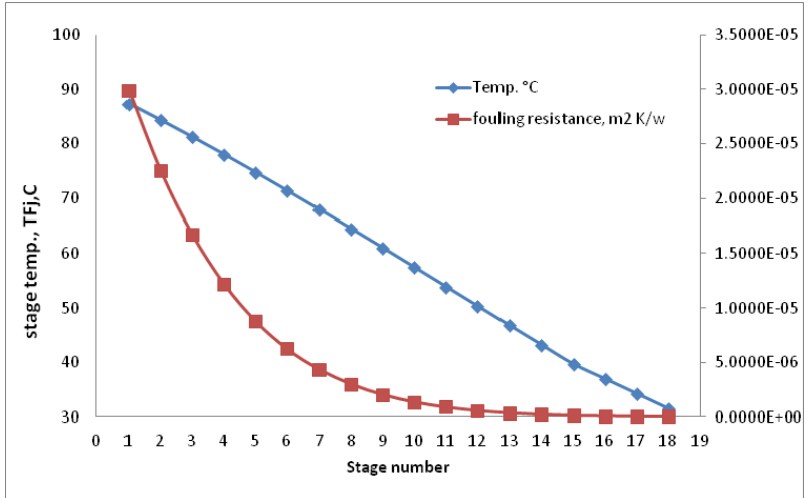
Figure 6. Stage temperature and fouling profile ( N = 18). Note: In y axis, E+00 = 10 0 ; E − 06 = 10 − 6 and